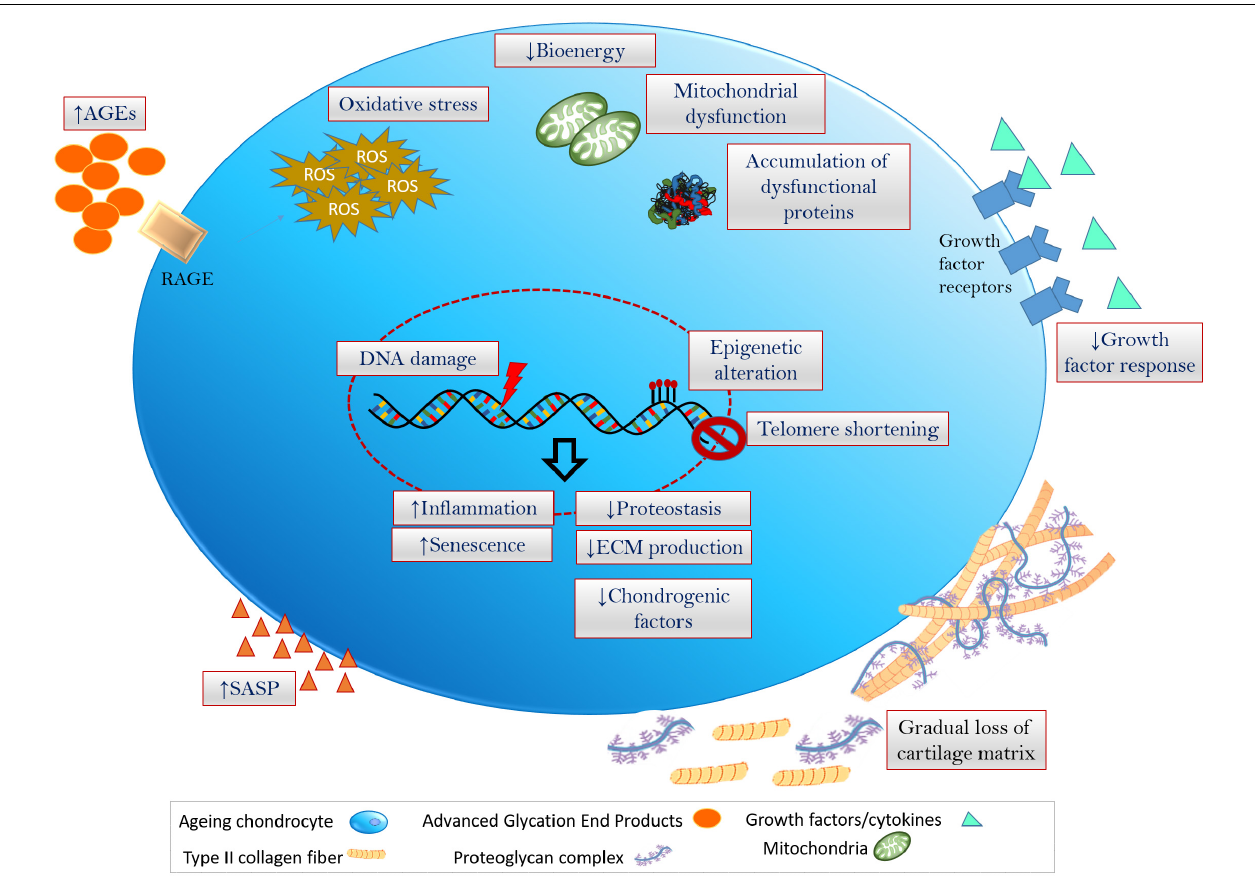
FIGURE 1 | Hallmarks of chondrocyte aging inflammation, oxidative stress (excess production and accumulation of ROS and the related dysfunctioning of cellular components) and senescence are fundamental events that is associated with the onset of cellular aging and aging-associated degenerative disorders. Chondrocytes undergoing aging at multiple levels including genetic/epigenetic aberration, disruption in biochemical and bioenergetics related cellular processes, modulation of ECM and cartilage niche, leading to the degeneration of cartilage and onset of